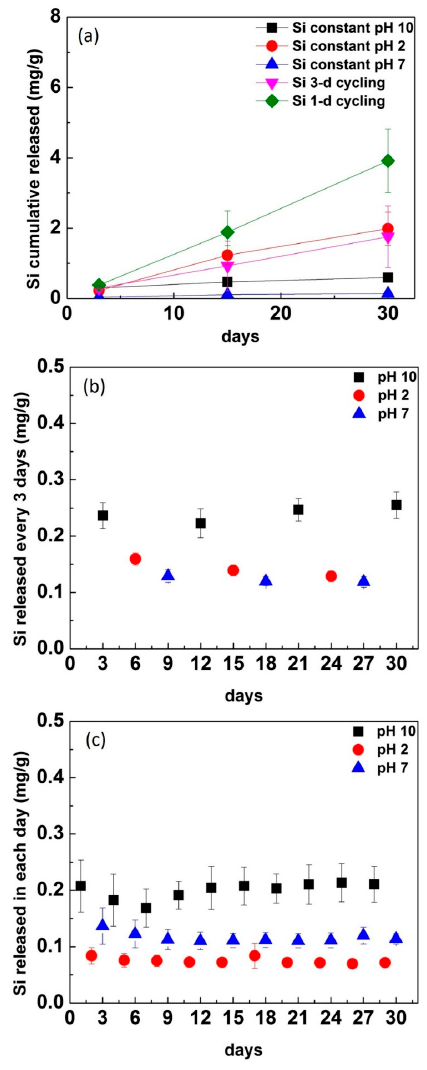
Figure 2. The cumulative Si 4+ ion released in each condition ( a ) and the Si 4+ released in each pH and time individually in ( b ) 3-d cycling and ( c ) 1-d cycling.